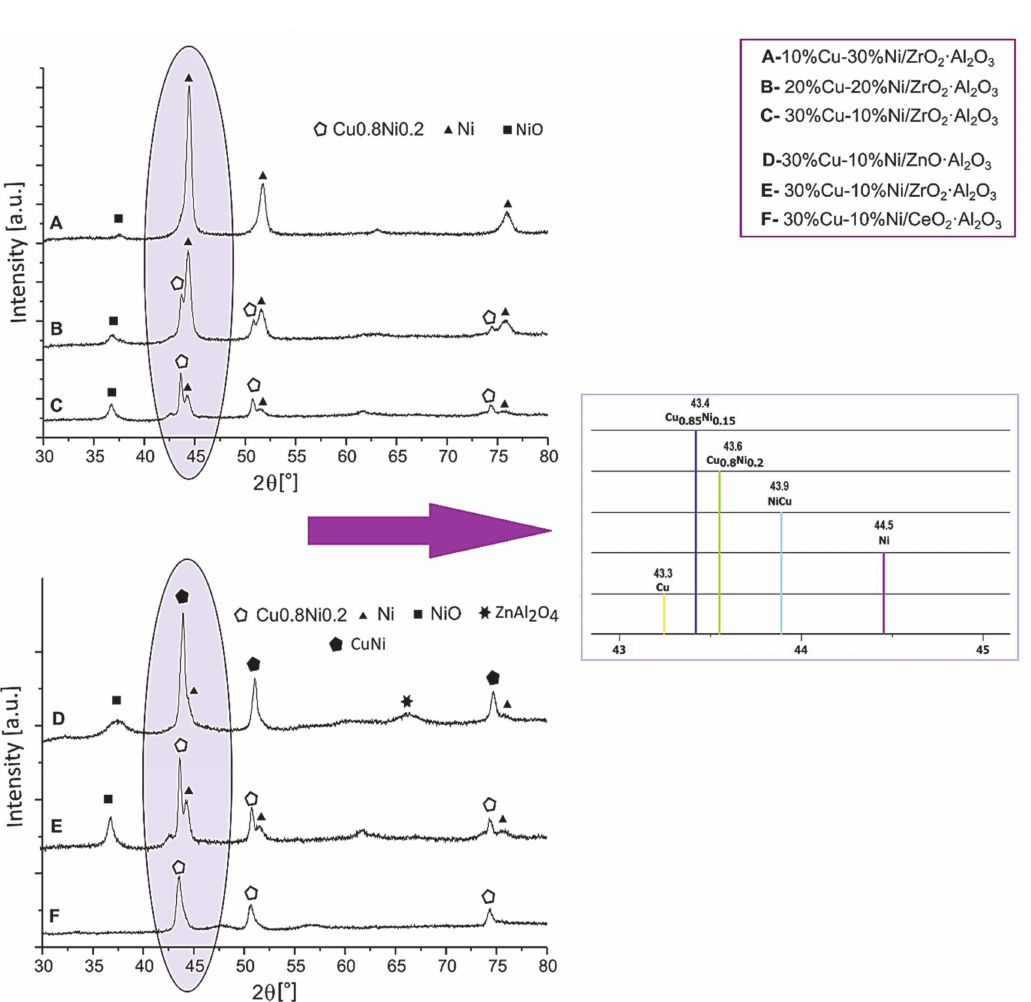
Figure 11. XRD patterns of spent bimetallic Cu–Ni systems